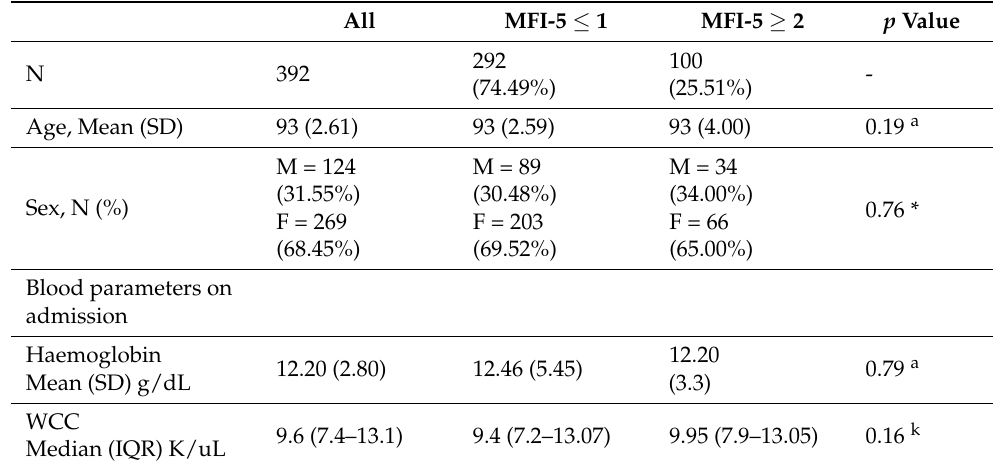
Table 1. Baseline characteristics of 392 older patients aged 90 years or over by MFI-5